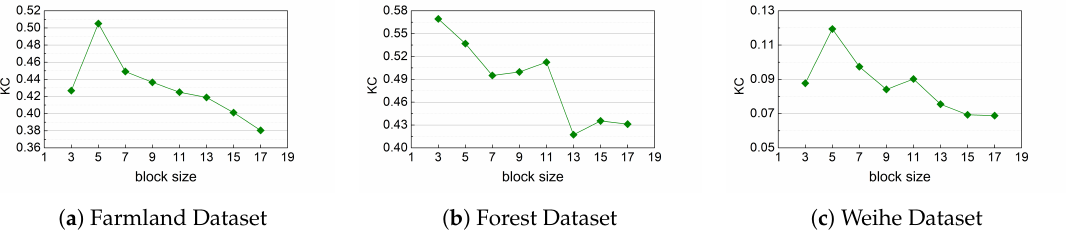
Figure 17. Relationship between parameter size of the pixel block and Kappa Coefficient